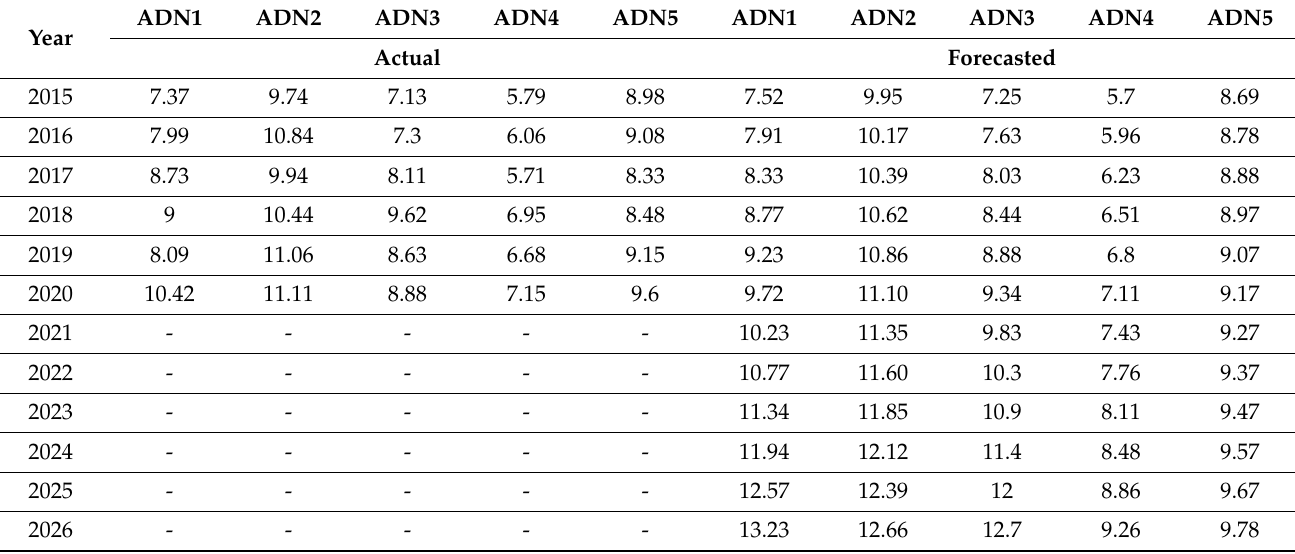
Table 2. Feeder peak load demand data’s from 2015 to 2020’ forecasted to